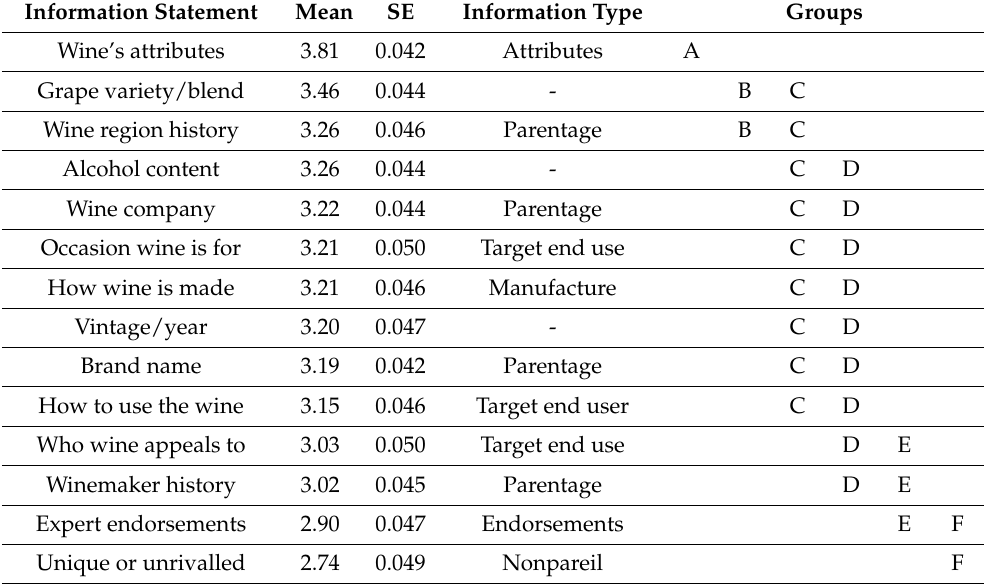
Table 3. The mean importance ratings (5-point Likert scale) for each sparkling wine information element. Differences in ratings determined using Tukey’s Honestly Significant Difference (HSD 0.05